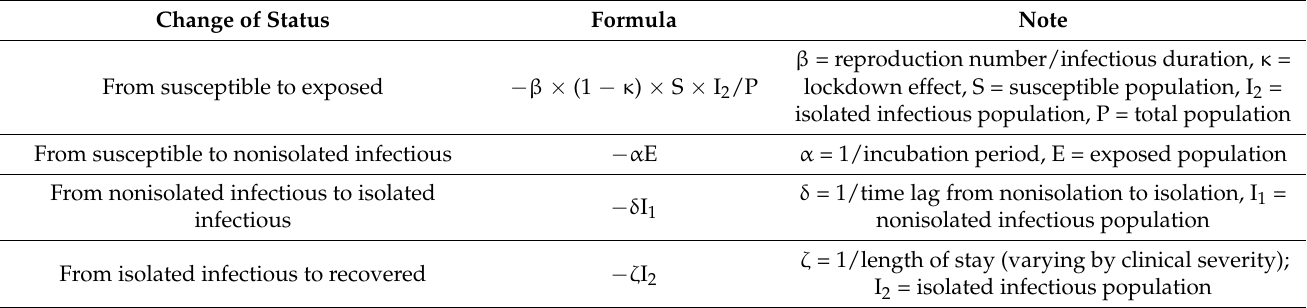
Table 3. The essential formula of the